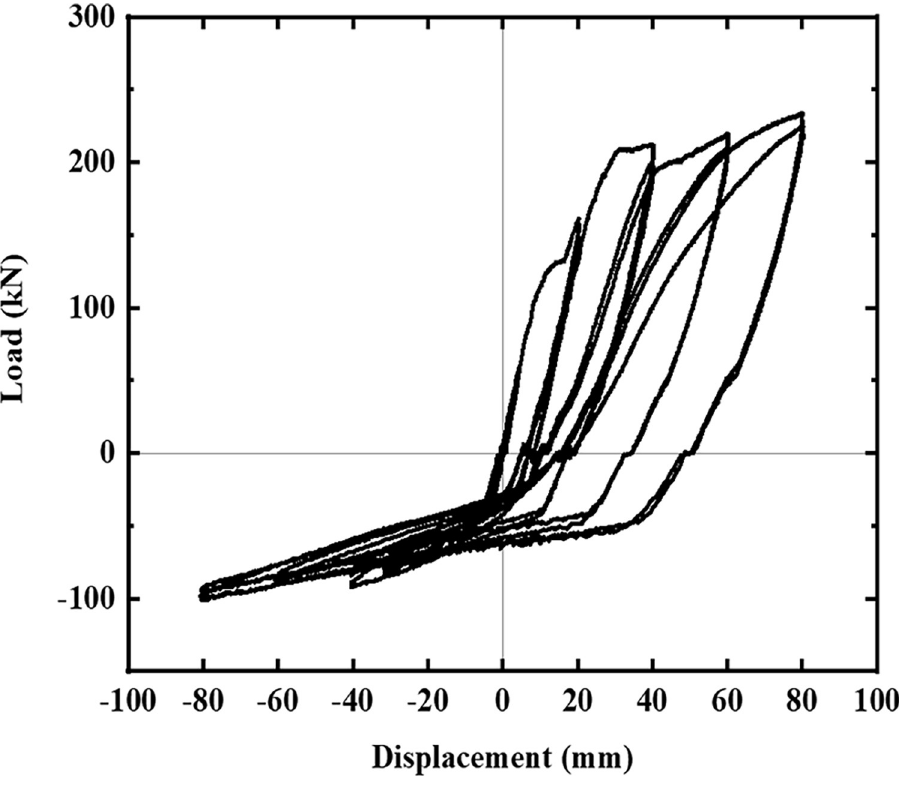
Fig 18. Hysteresis curve of